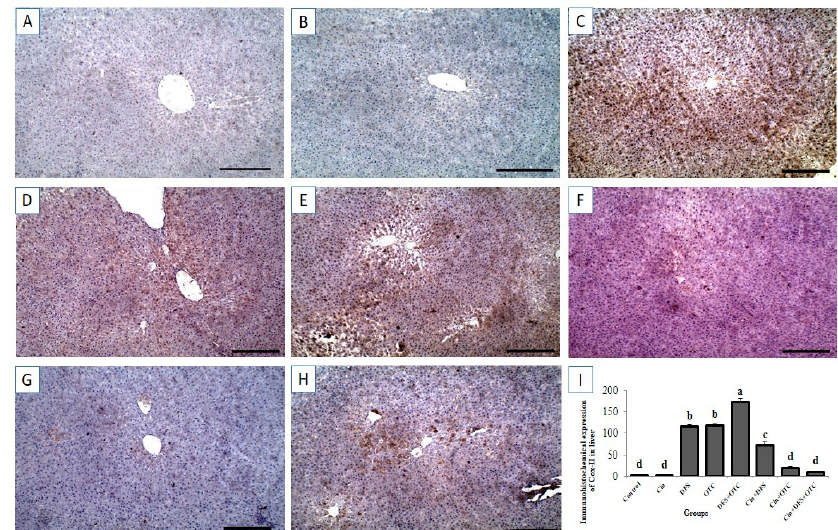
Figure 7. Immunohistochemical staining of rat liver by Cox-II. ( A , B ) control and cinnamon groups: Showing negative Cox-II reaction in the liver sections. ( C , D ) DFS and OTC groups: Revealing strong positive Cox-II reaction in the hepatocytes. ( E ) DFS+ OTC group: Showing higher expression levels of Cox-II relative to those in rats treated with DFS or OTC alone ( F ) DFS + Cin group: Revealing weak Cox-II reaction. ( G ) OTC + Cin group: Nearly negative Cox-II reaction. ( H ) DFS + OTC + Cin group: Showing reduction in Cox-II reaction compared to DFS + OTC group. ( I ) Quantification of Cox-II in the liver tissues in different groups. Data are presented as the mean ± SEM (n = 5), analyzed using one way ANOVA and each bar carrying different letters (a, b, c, d) is significantly different ( p < 0.05). Scale bar = 100 µ m.